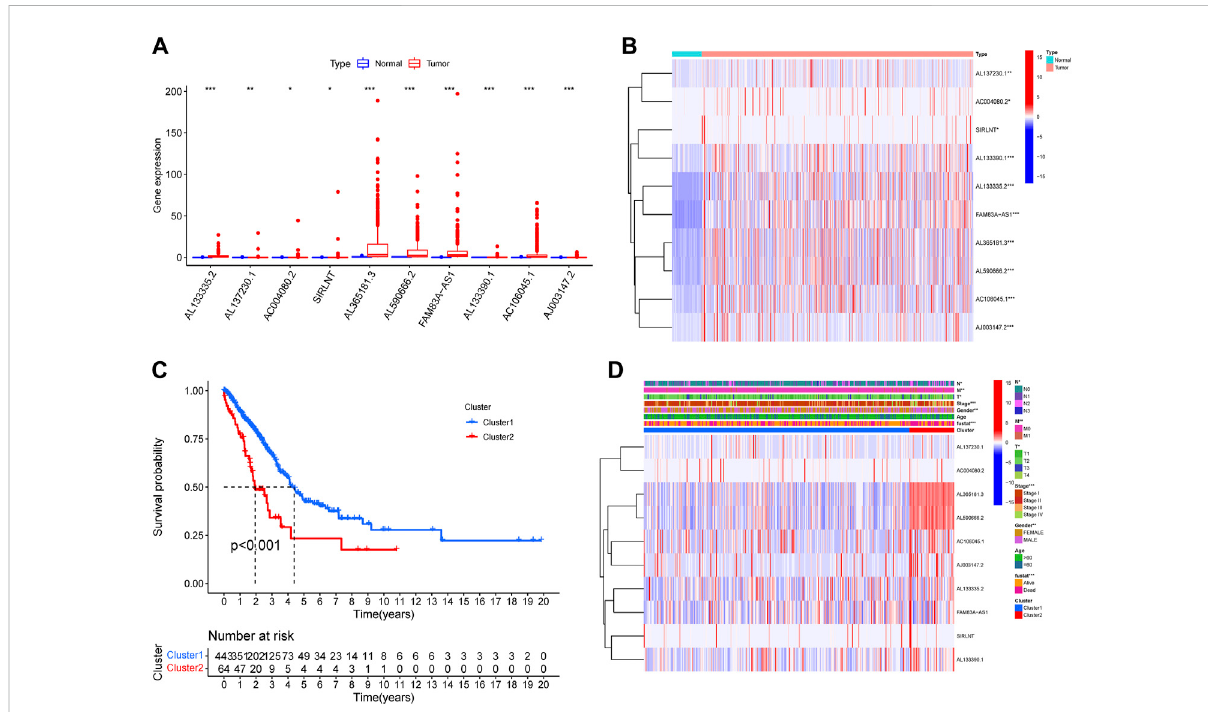
FIGURE 1 Different prognosis andclinicopathologicalfeatures oftwoLUAD clusters.Boxplot (A) andheatmap (B) revealed thedifference inexpression of 10 NETs-associated lncRNA in normal and tumor tissues (C) The overall survival rate of LUAD patients in the two clusters was calculated by Kaplan- Meier curve (D) Heatmap exhibited the differences in expression of 10 NETs-associated lncRNA and clinicopathological features of two LUAD clusters (* p < 0.05, ** p < 0.01, *** p <